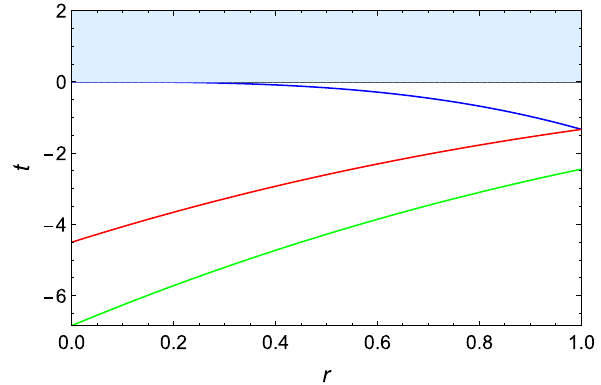
Fig. 3 ζ = 0, OS model with K = 0. The green line corresponds to the photon surface, the red line is the event horizon, and the blue line depicts the apparent